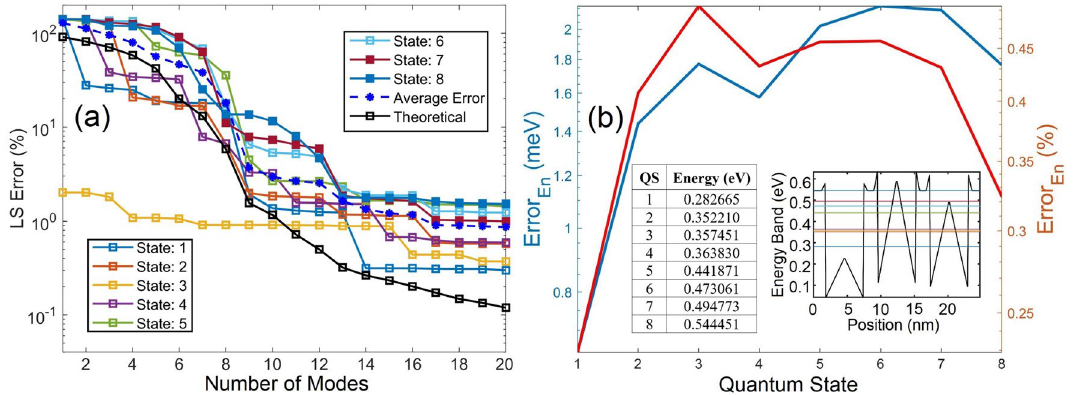
Figure 11. ( a ) POD LS errors for WFs in QSs 1–8. The average LS error is averaged over the 6 trained QSs, and the theoretical LS error Err M , ls is also for the first 6 QSs. ( b ) Absolute error of the estimated POD eigenenergy with two insets including the eigenenergy obtained from the DNS, one in a table and the other in a band diagram along the diagonal of the QS structure in Fig. 7 from (0,0) to (17.5 nm, 17.5